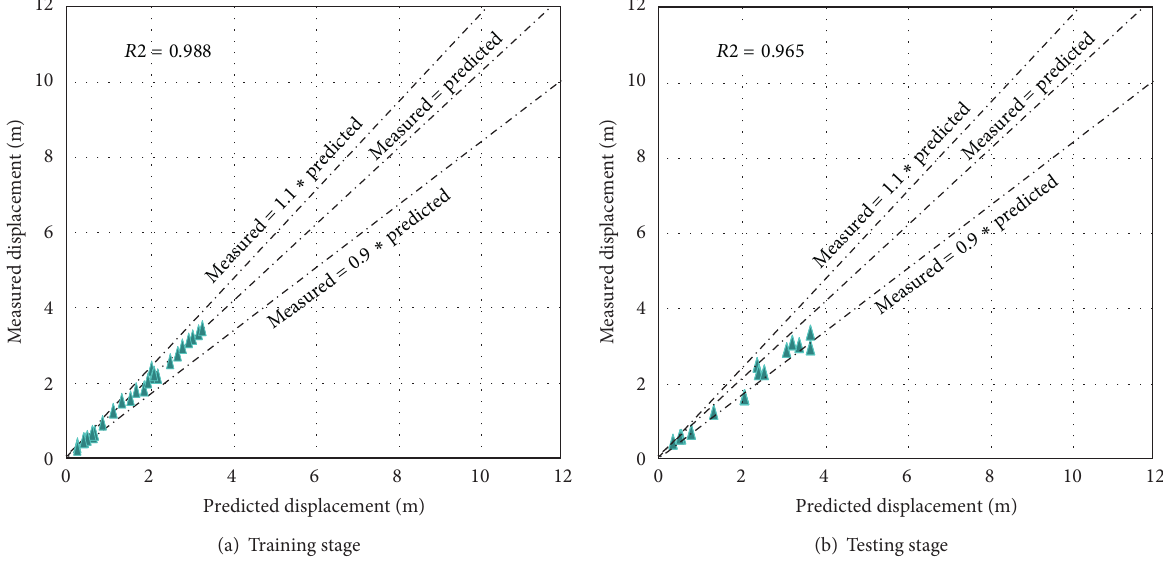
Figure 37: Comparison between NEFLAS and measured lateral spread, San Francisco, USA. (a) Training stage and (b) testing